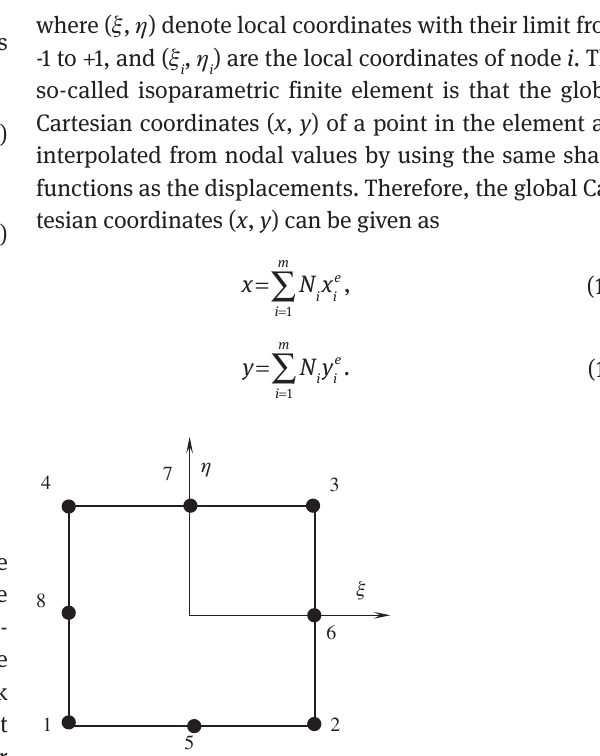
Figure 2: Quadrilateral element of eight